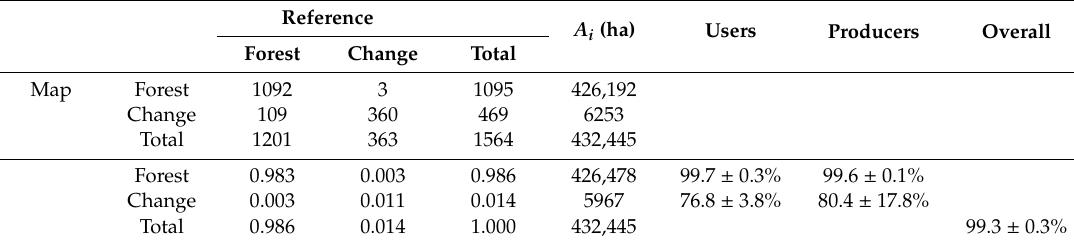
Table 7. Error matrix for Austria, plausibility